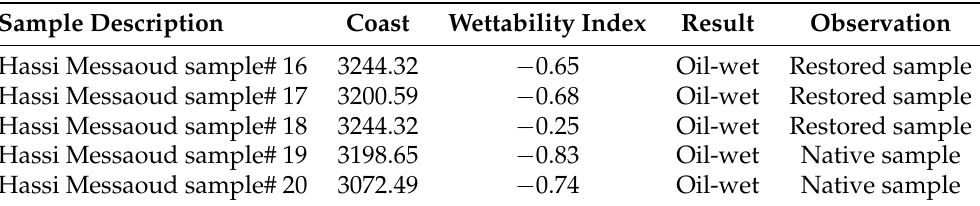
Table 2. Description of the experimental results including the sample description, coast, wettability index and